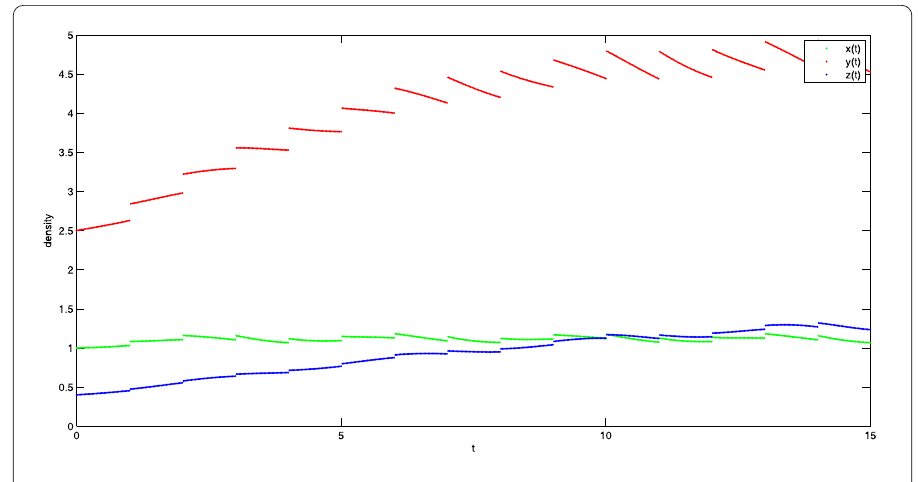
Figure 1 Permanence of system with initial condition φ 1 ( s ) = x 1 (0) = 1.0, φ 2 ( s ) = y 1 (0) = 2.5, φ 3 ( s ) = z 1 (0) = 0.4, s ∈ [– τ